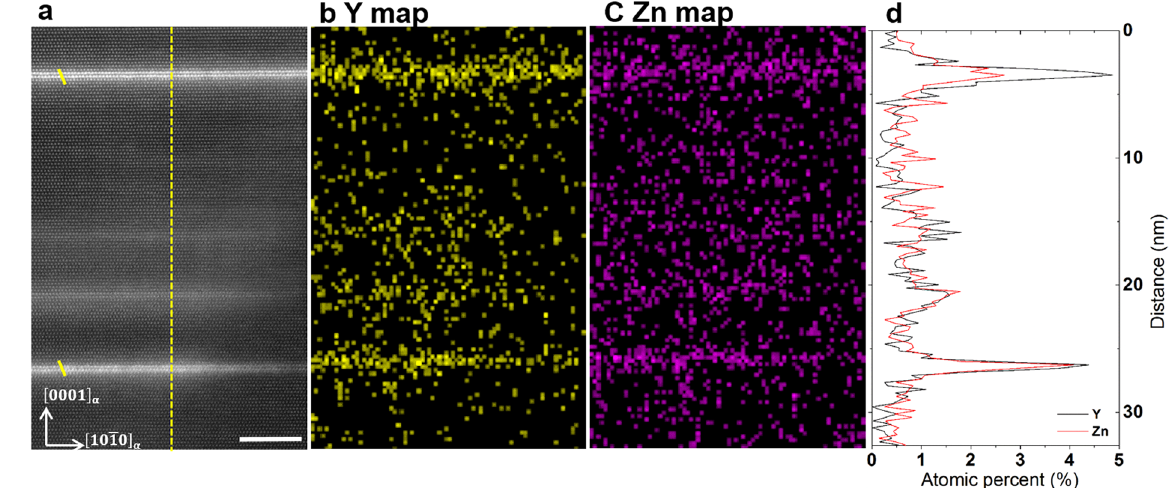
Figure 3. Correlative HAADF-STEM and EDXS analysis for the GP zones and LPSO building blocks. ( a ) HAADF-STEM image of the Mg-1Y-0.5Zn alloy after solution annealing for 10 h at 500 °C. Beam direction is [1210] . Four basal plane defects which are either GP zones or LPSO building blocks. The yellow lines illustrate the stacking sequence of the LPSO building blocks. Scale bar width is 5 nm. ( b , c ) Correlative TEM-EDXS atomic distribution maps of Y and Zn atoms. ( d ) The quantitative concentrations of Y and Zn in at. % along the line drawn in ( a ). It is evident that the LPSO building blocks are more enriched in Y/Zn atoms than the GP zones.